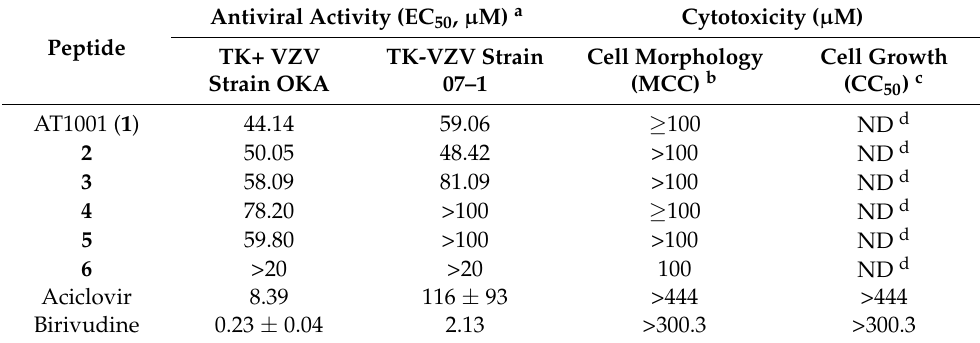
Table 3. Activity of the synthesized peptides against varicella-zoster virus (VZV) in human embryonic lung (HEL)